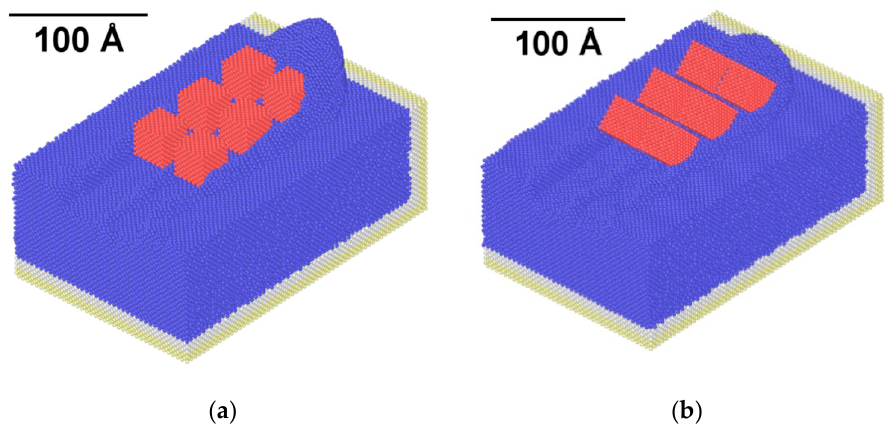
Figure 8. Snapshots of nanogrinding with abrasive grain rake angle of: ( a ) 0° and ( b ) − 45°.